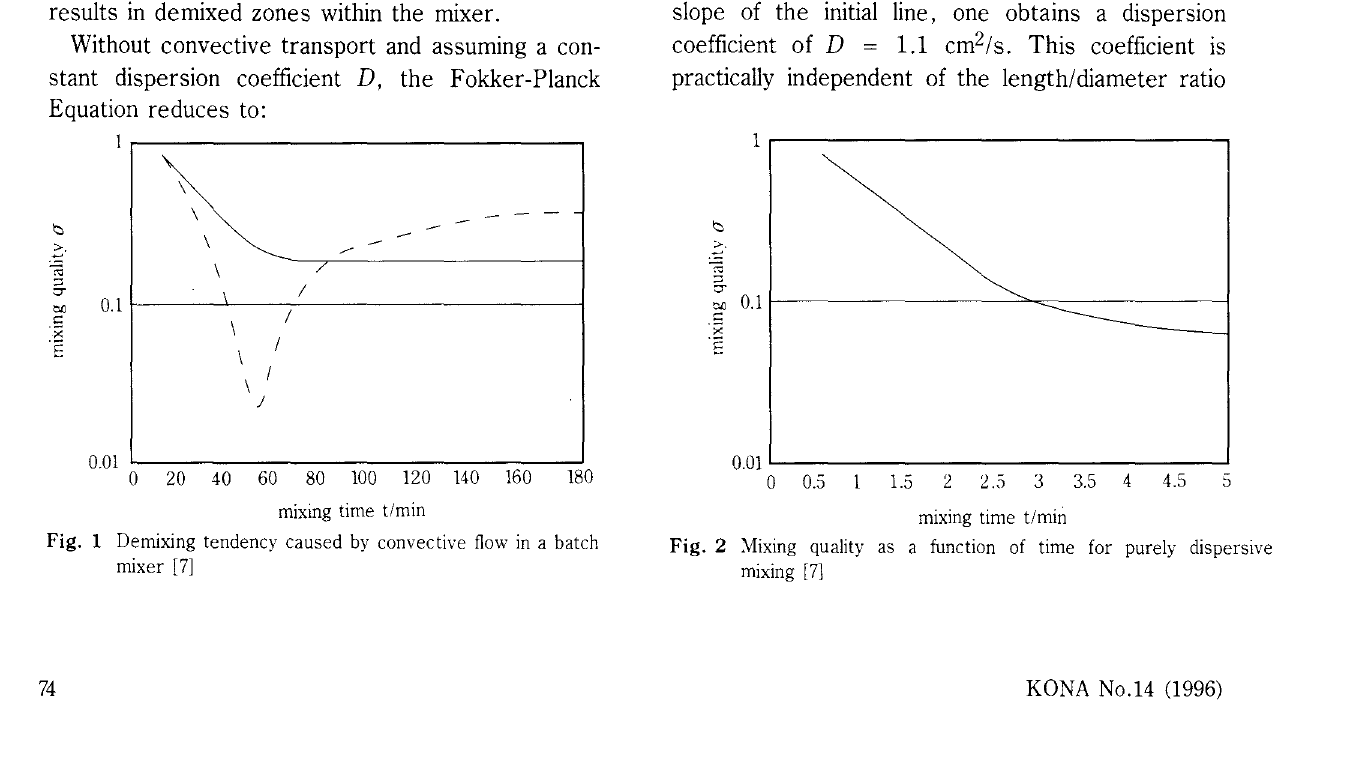
Fig. 2 Mixing quality as a function of time for purely dispersive mixing [7]